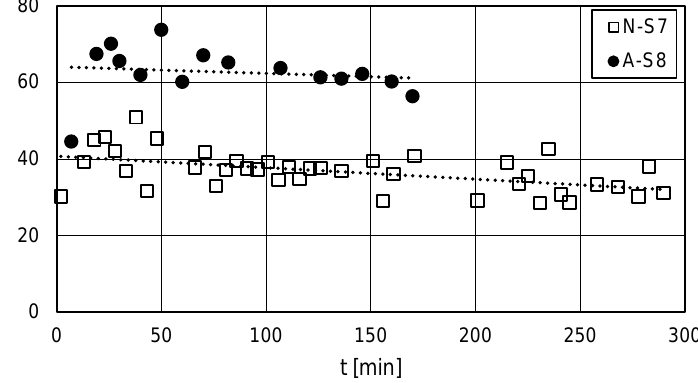
Figure 8. Permeate flux vs. time during the RO process conducted using the AG Osmonics membrane and the MTW containing an anionic (A-S8) or a nonionic agent (N-S7).